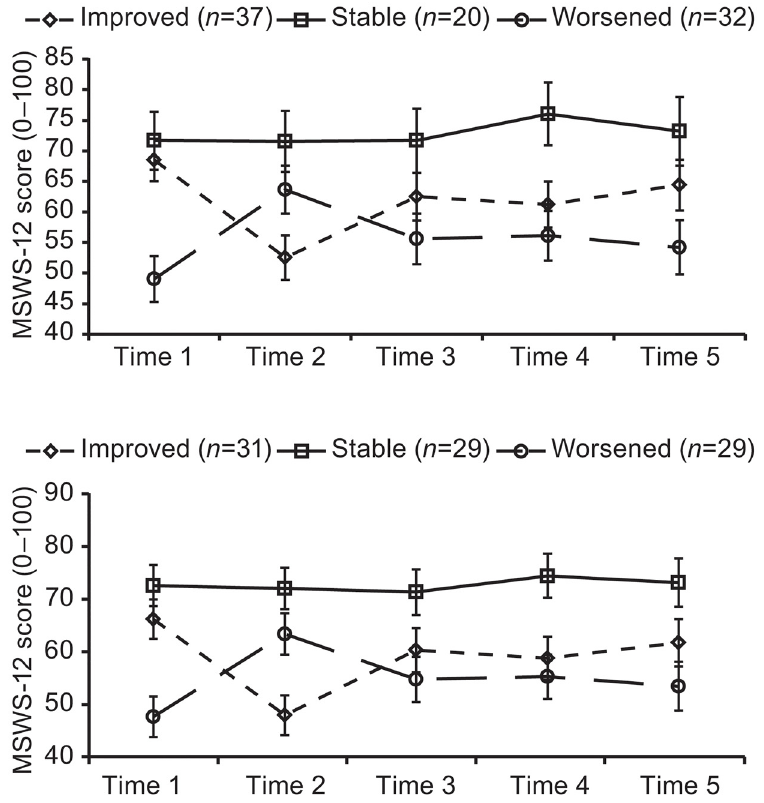
Fig 1. Change in 12-item Multiple Sclerosis Walking Scale (MSWS-12) scores over 2 years. Patients with relapsing-remitting multiple sclerosis were categorized as improved, stable, or worsened across the initial 6-month time period based on minimal clinically important difference values of 4 (top panel) and 6 (bottom panel).